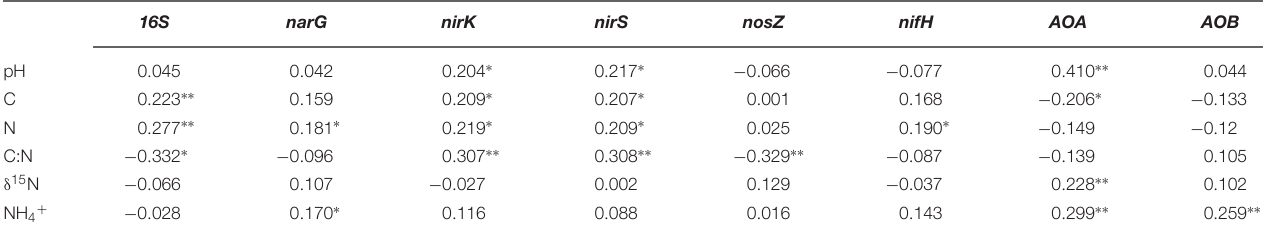
TABLE 4 | Pearson coefficients for correlation between functional gene abundances and soil characteristics, Kolombangara, Solomon